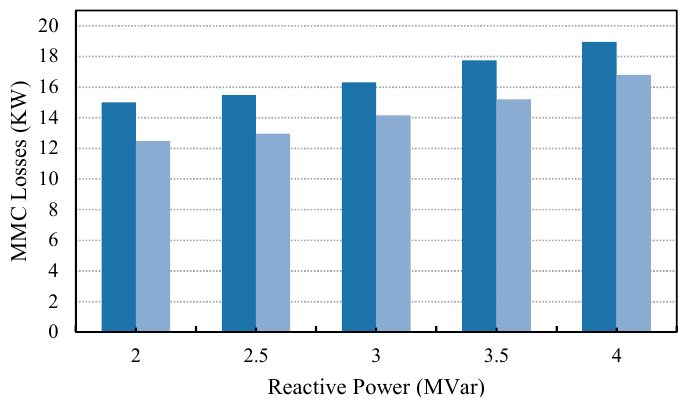
Figure 11. MMC losses with and without circulating current control.